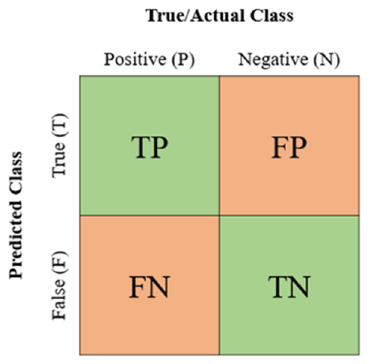
Figure 4. Confusion Matrix.